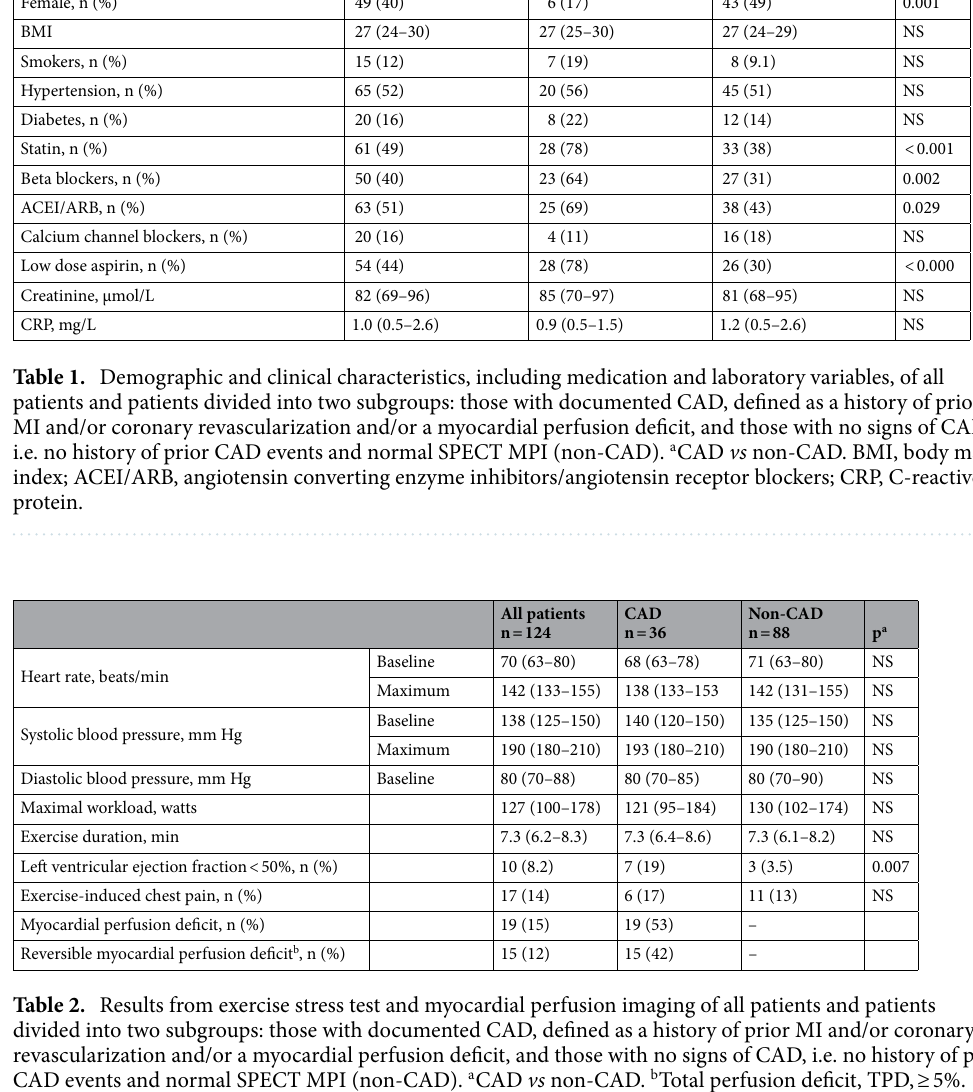
Table 2. Results from exercise stress test and myocardial perfusion imaging of all patients and patients divided into two subgroups: those with documented CAD, defined as a history of prior MI and/or coronary revascularization and/or a myocardial perfusion deficit, and those with no signs of CAD, i.e. no history of prior CAD events and normal SPECT MPI (non-CAD). a CAD vs non-CAD. b Total perfusion deficit, TPD, ≥ 5%.